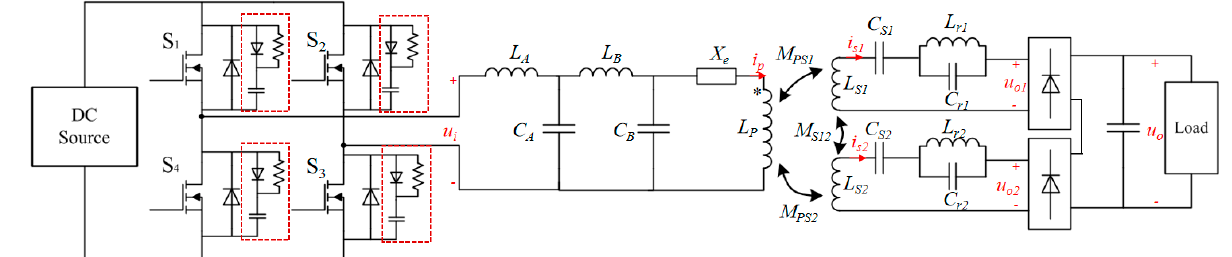
Figure 5. Dual-resonant-frequency wireless power transfer system.